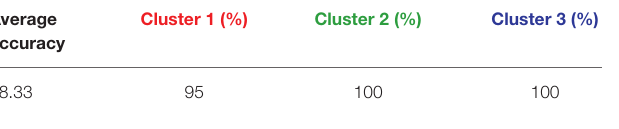
TABLE 5 | Cross-validation accuracy of the decision tree classification